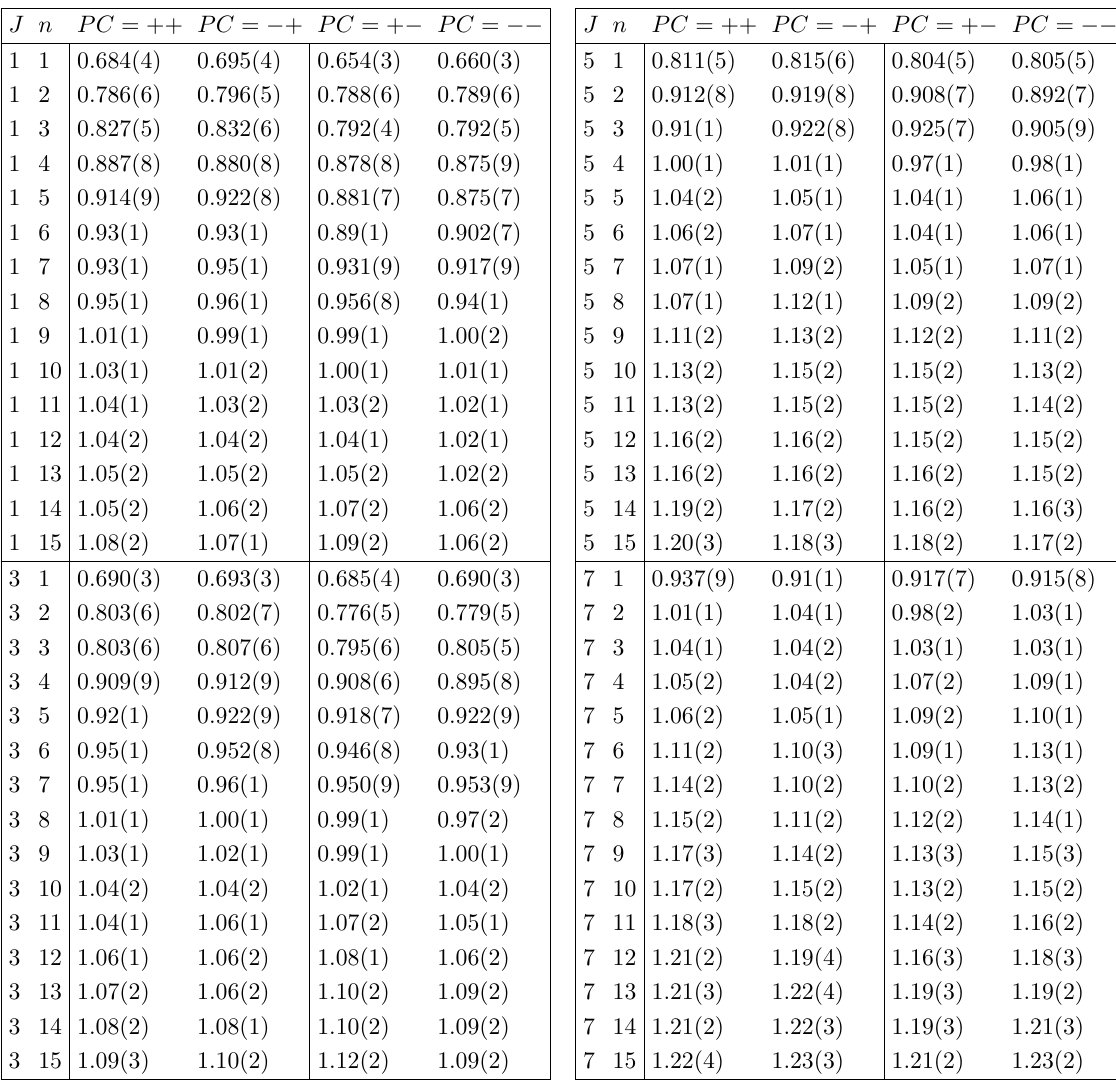
Table 5. Masses (in lattice units) for glueballs in E representation of Z 4